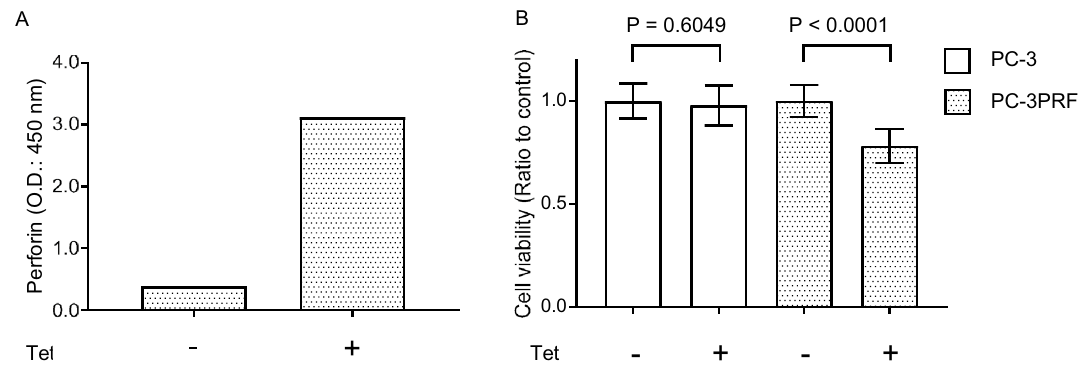
Figure 1. Effect of perforin induction on growth of PC-3PRF cells. ( A) PC-3PRF cells in which perforin expression was controlled by Tet-On system were treated with tetracycline (1 μg/ml). Seventy-two h after treatment, the perforin level in conditioned medium was measured by ELISA. ( B) PC-3PRF cells and their parental PC-3 cells were treated with tetracycline (1 μg/ml). Six days after treatment, cell viability was determined by WST-1 assay. Data shown are mean with SD (n = 10 in each group). Statistical significance was calculated using